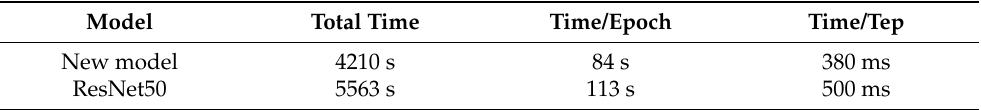
Table 9. Computational cost of the ResNet50 model and proposed model for the Intel image classifi- cation dataset.